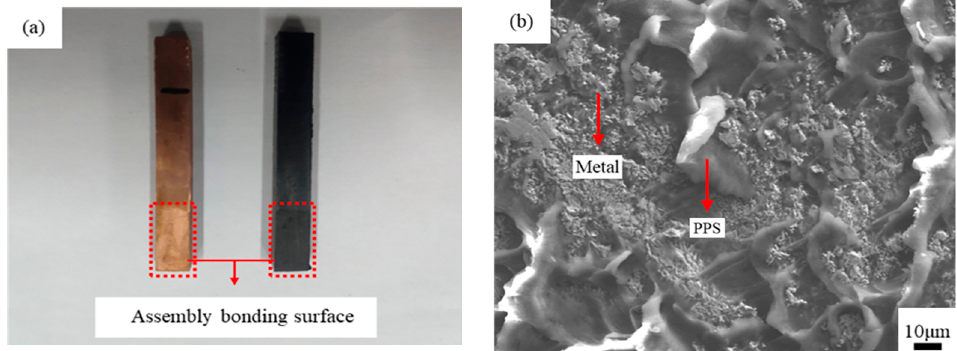
Figure 13. The fracture interface between copper and PPS. ( a ) schematic representation; ( b ) SEM